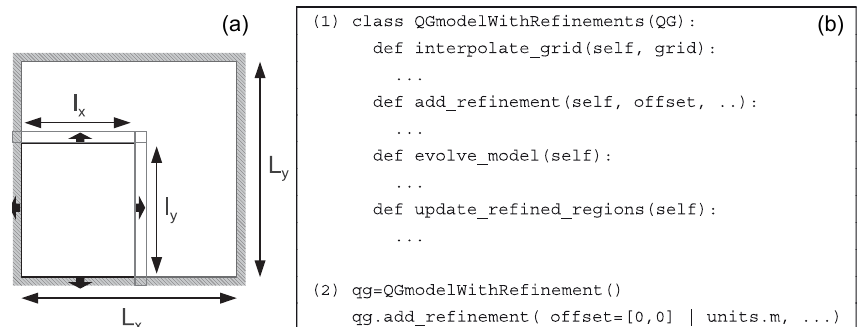
Figure 9. Schematic (a) and (abbreviated) definition of the refined QG model class (b) with an example (2) of its